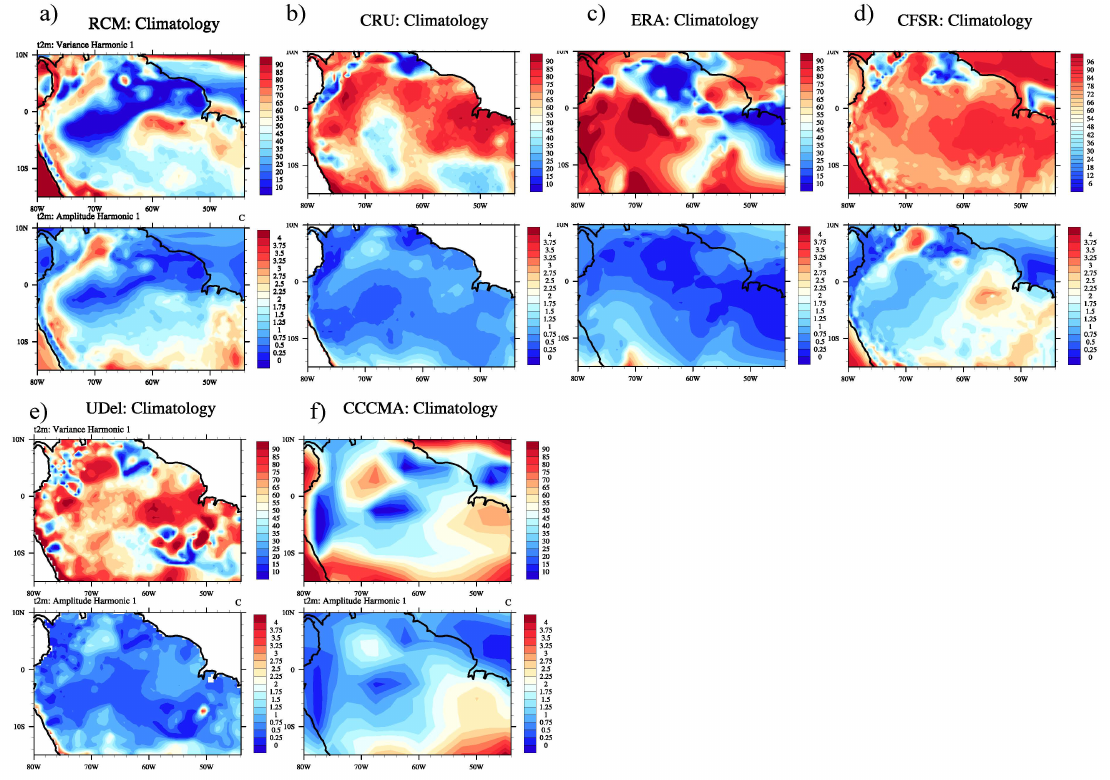
Figure 1. Explained variance (top panels %) and amplitude (lower panels ˝ C) of the first harmonic of t2m. ( a ) PD-RCM simulation ( b ) CRU, ( c ) ERA-Interim, ( d ) CFSR, ( e ) University of Delaware dataset, and ( f ) the